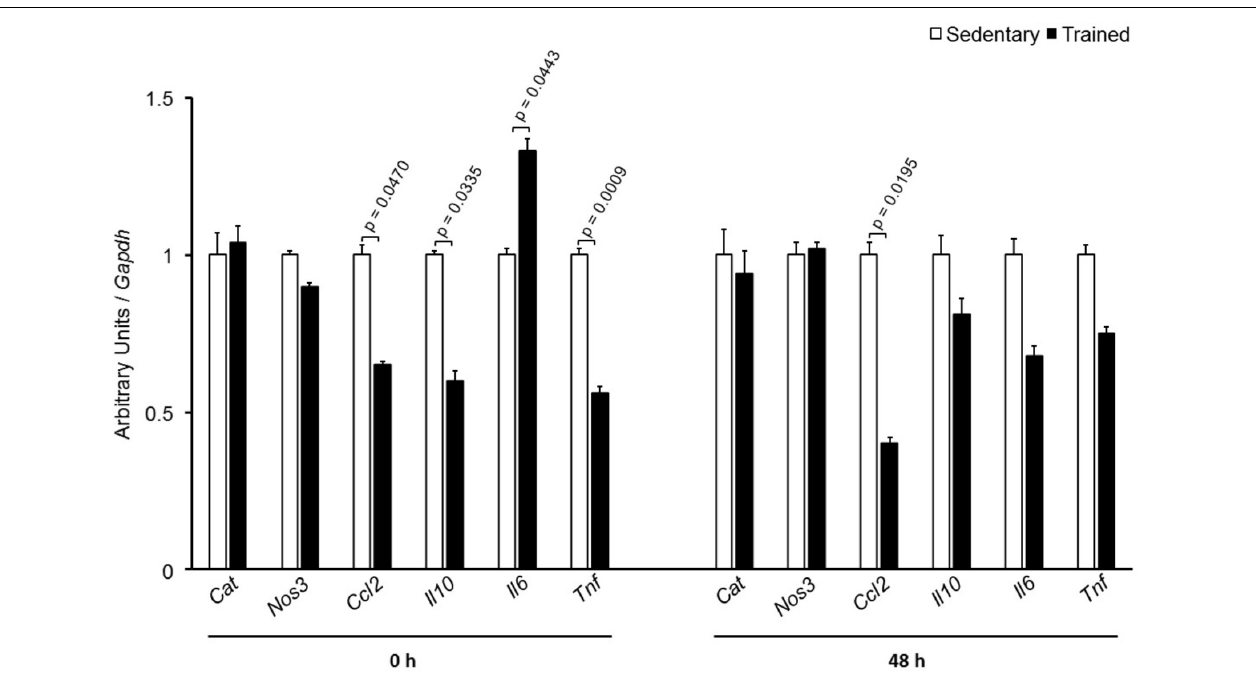
FIGURE 4 | Expression of inflammation-related genes in the aortic arch of sedentary (S) and trained (T) mice. The aortic arch was removed from CETP-tg S ( n = 7) and T ( n = 6) mice immediately (0 h) or 48 h after the last session of exercise. The expression of genes was analyzed by RT-qPCR and expressed as arbitrary units corrected per Gapdh . Comparisons were done by the unpaired Student t -test (mean ±